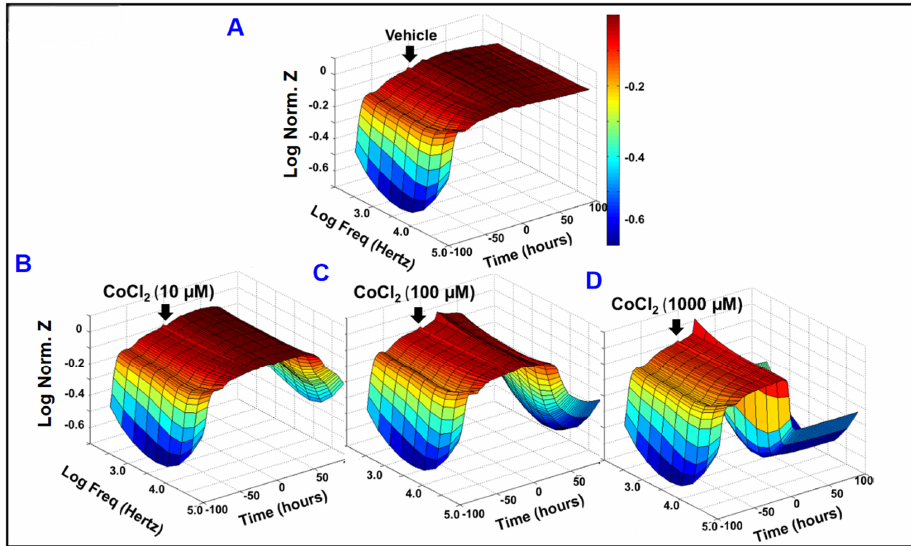
Figure 1. Effects of cytopathic hypoxia on the barrier function of ARPE-19 cells monitored by real-time bioimpedance analysis. Three dimensional representations of the log of normalized impedance across the ARPE-19 cells as a function of both time and of log frequency of the alternating-current (AC) frequency applied to the electrode. T = 0, the time at which control (vehicle) or CoCl 2 treatment was applied, was 93.17 h after cells were first placed onto the ECIS electrode. Impedance was measured for 100 h after CoCl 2 -treatment at different concentrations (0, 10, 100, and 1000 µ M; Figures A , B , C , and D , respectively) was applied at T = 0. The value of impedance was normalized to a value of 1 at time T = 0, so all other impedance measurements were calculated as a ratio of Zt/Z0. AC current frequencies used were 250, 500, 1000, 2000, 4000, 8000, 16,000, 32,000, and 64,000 Hz. Abbreviations: Z, impedance; Norm, normalized; Freq, frequency; Zt, impedance at time t; Z0, impedance at time